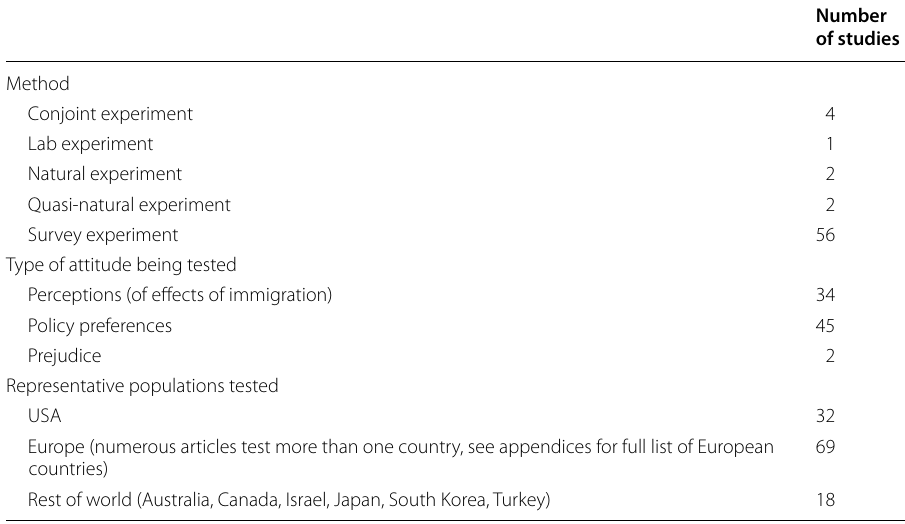
Table 2 Descriptive statistics of 68 reviewed